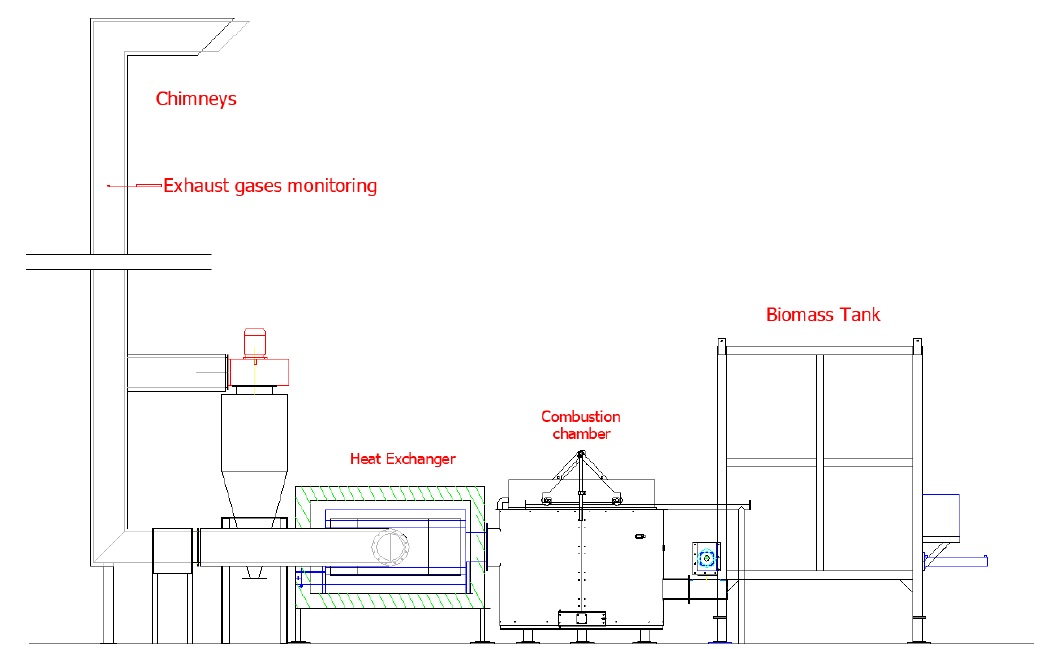
Figure 3. Front view of the plant and exhaust gases monitoring position.